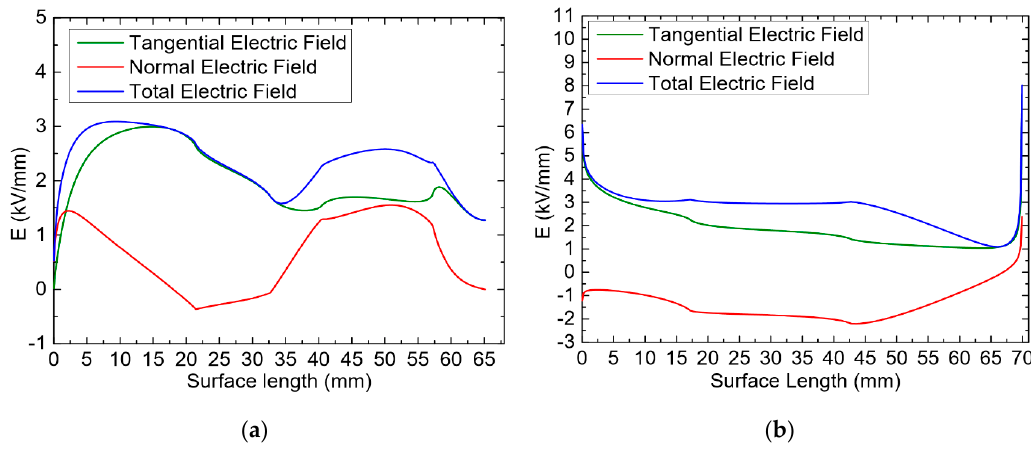
Figure 8. Computed tangential, normal, and total electric field distributions on the lower surface of the optimized spacer ( a ) in comparison with that of the initial configuration ( b ).